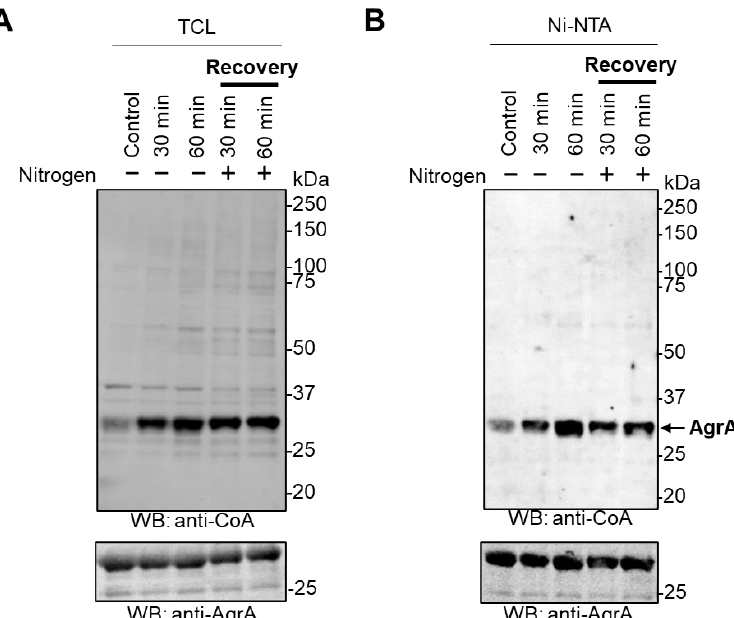
Figure 4. Nitrogen deprivation induces CoAlation of Sa AgrA in E. coli . Nitrogen-deprived cultures of E. coli cells transformed with the pET28/His- Sa AgrA were cultured in Gutnick minimal medium lacking a source of nitrogen for 30 or 60 min. They were then re-supplemented with 10 mM NH 4 Cl as the sole nitrogen source and incubated at 37 °C for the indicated times. CoAlation in total protein extracts ( A ) or of Ni-NTA pulled-down Sa AgrA ( B ) was examined by anti-CoA Western blot. The respective amounts of Sa AgrA are shown by Western blot with anti-AgrA antibodies. The figures shown are representative of at least three independent repeats.